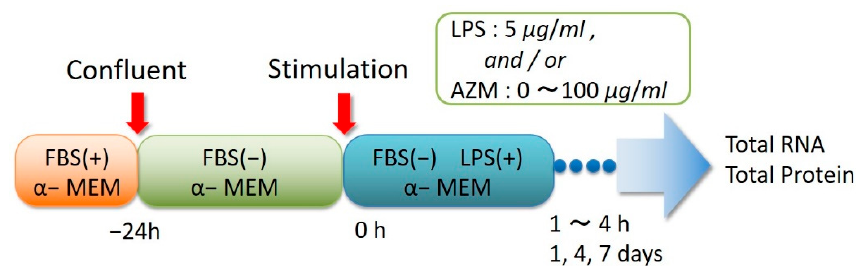
Figure 1. Experimental protocol.